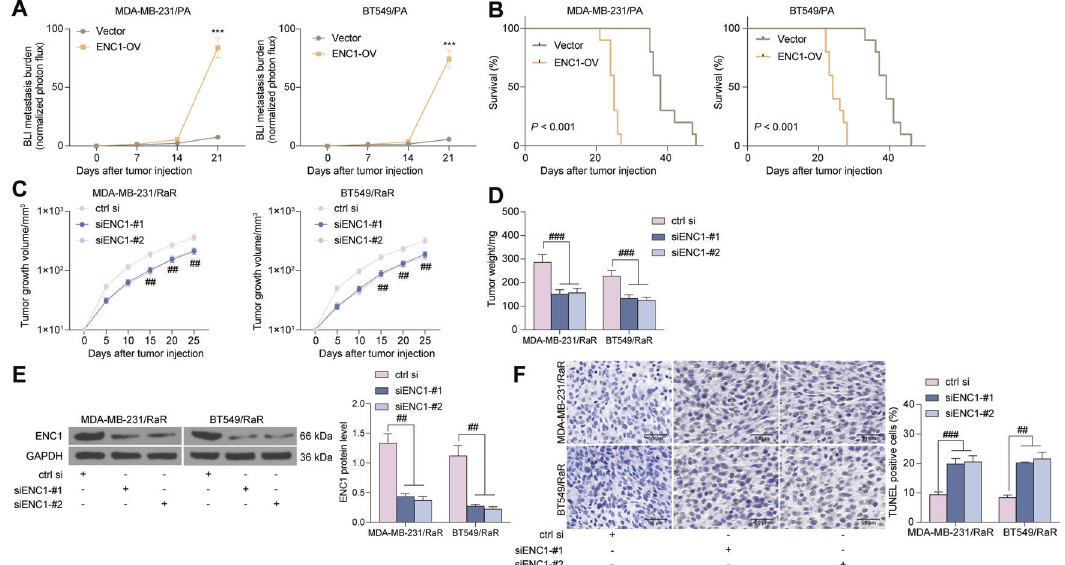
Fig. 3 ENC1 knockdown sensitizes BC cells to radiotherapy in vivo. A The metastatic ability of MDA-MB-231/PA and BT549/PA cells overexpressing ENC1 in mice ( n = 6). B analysis of the survival of mice after injection of MDA-MB-231 and BT549 cells ( n = 10). C , D tumor growth curve ( C ) and weight ( D ) of nude mice injected with MDA-MB-231 and BT549 cells with ENC1 knockdown ( n = 6). E ENC1 protein expression in tumor tissues examined using western blot. F Apoptosis rate in xenograft tumors examined by TUNEL staining. All the data are expressed as the mean ± SD. Two-way ANOVA with Tukey ’ s multiple comparison test were utilized to detect signi fi cant differences between data. *** p < 0.001; ## p < 0.01, ### p <